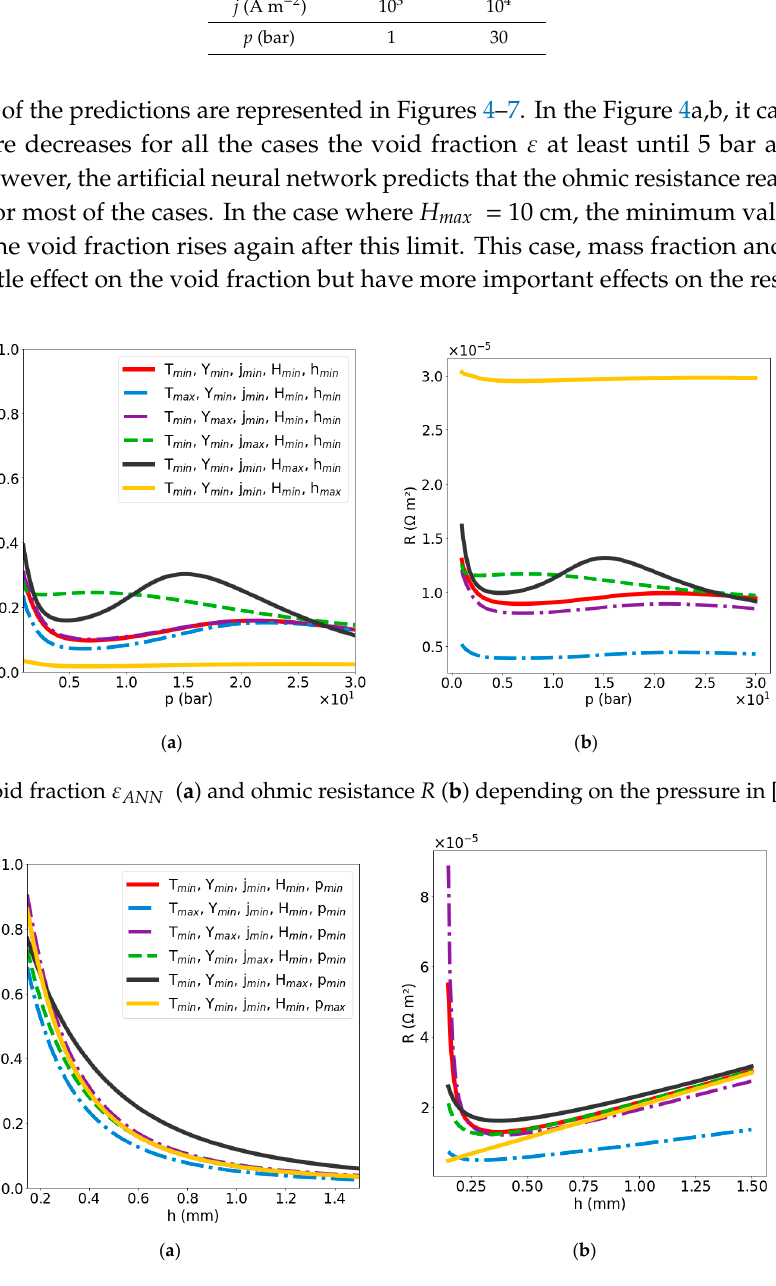
Table 3. Minimum and maximum of the explored parameters for the sensitivity analysis.